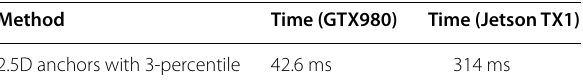
Table 4 Process time in person detection and its distance measurement